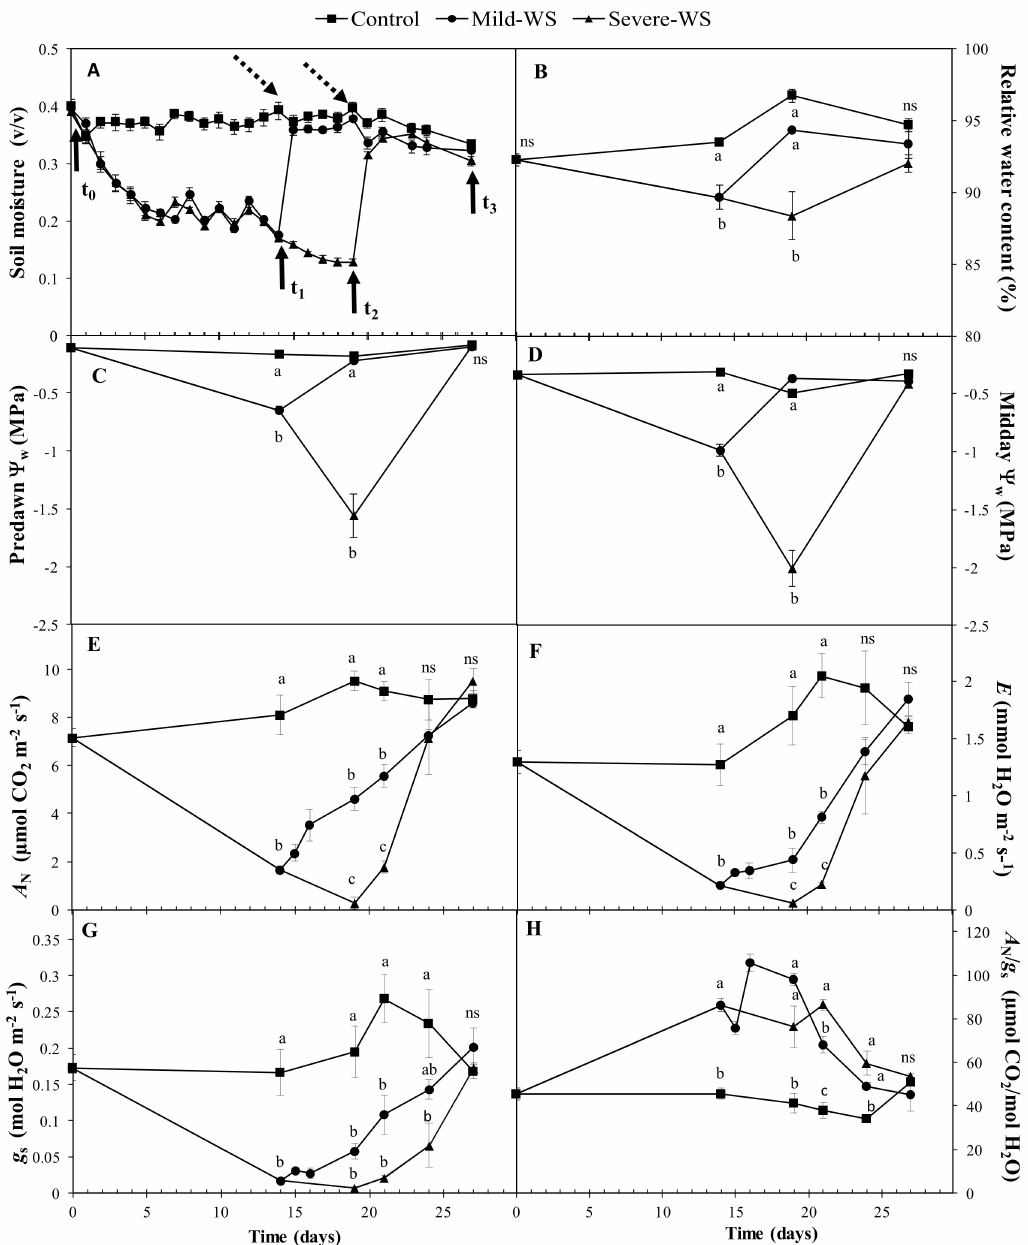
Figure 2. Time-course of mean values ( ± SE; n = 4 to 16) of volumetric soil moisture ( A ), relative water content ( B ), predawn ( C ) and midday leaf water potential ( Ψ w ; D ), net CO 2 assimilation rate ( A N ; E ), transpiration rate ( E ; F ), stomatal conductance ( g s; G ), and intrinsic water use efficiency ( A N / g s ; H ) of ‘Dusa’ plants subjected to three water treatments: control, mild-WS (50% Fc), and severe-WS (25% Fc). Solid arrows indicate the timepoints where measurements and samplings were done, while dotted arrows show rewatering days. Different letters indicate significant differences among treatments for the specific timepoints (days) ( p < 0.05; ns: no statistical